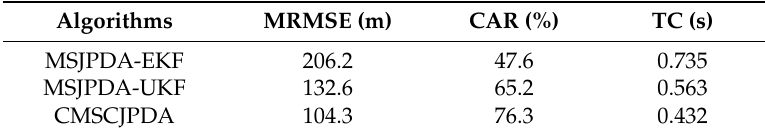
Table 4. Performance comparison of three algorithms.